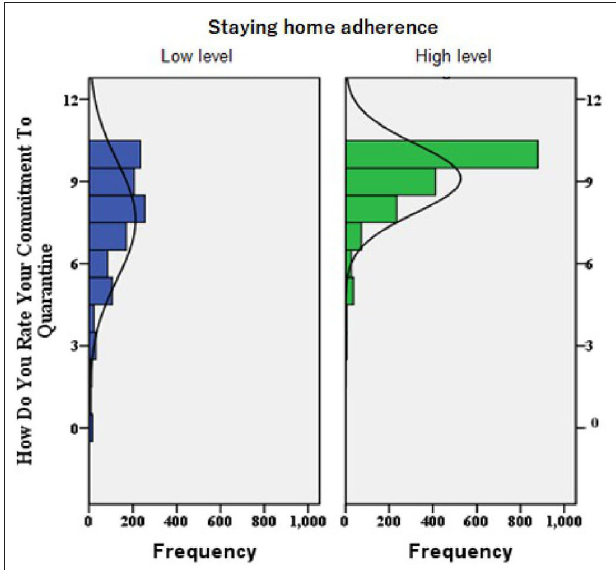
FIGURE 1 | A histogram chart built for the distribution of participants’ self-rating of adherence to quarantine among the high and low levels of staying home adherence ( P -value of t -test analysis for the mean difference between the two groups was < 0.001; i.e., High-level group showed significantly higher Mean ± SD self-rating of adherence to quarantine compared to low-level, 9.11 ± 1.26 and 7.56 ± 2.15,